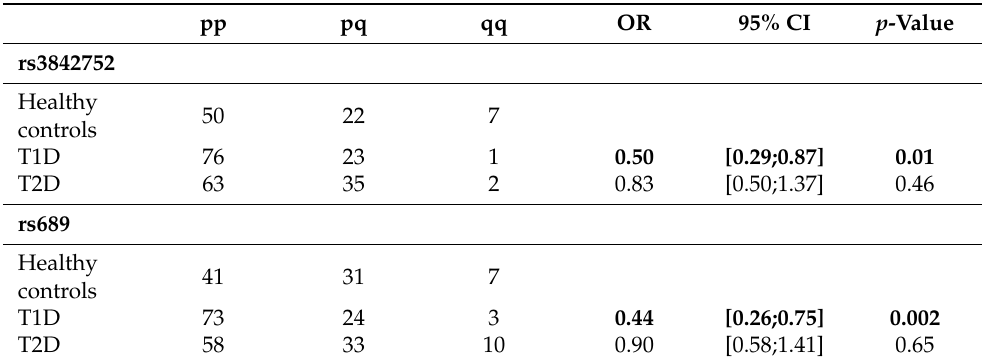
Table 2. Associations between selected polymorphisms in the INS gene and T1D ( n = 100) or